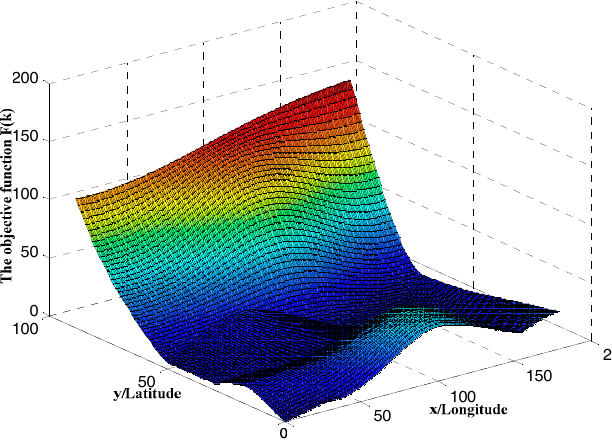
Figure 4. Theamplitudecharacteristicoftheobjectivefunction. Figure 4. The amplitude characteristic of the objective